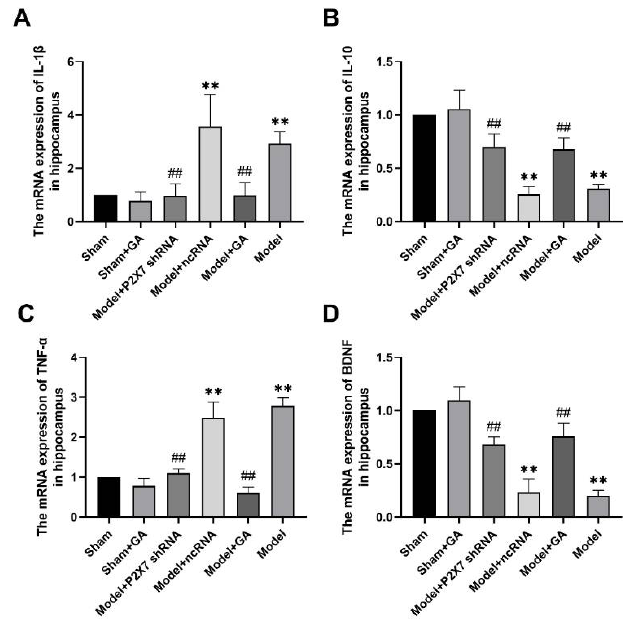
Figure 10. The effects of GA on the mRNA level of IL-1β ( A ) (F(5,30) = 24.350, p < 0.001); IL-10 ( B ) (F(5,30) = 62.094, p < 0.001), TNF-α ( C ) (F(5,30) = 123.893, p < 0.001); and brain-derived neurotrophic factor (BDNF) ( D ) (F(5,30) = 94.780, p < 0.001) in the hippocampus of rats in each group were assessed using qRT-PCR. β-Actin was used as the housekeeper gene in all qRT-PCR. Values are means ± SEM. N = 6 per group. ** p < 0.01 vs. sham group; ## p < 0.01 vs. model group.